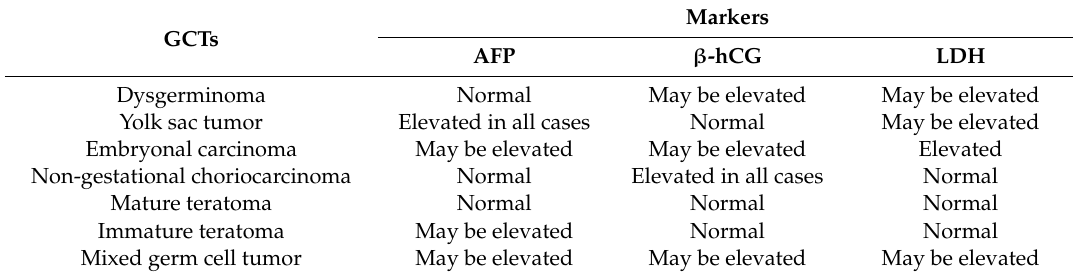
Table 2. Germ cell tumors (GCTs) and their tumor markers